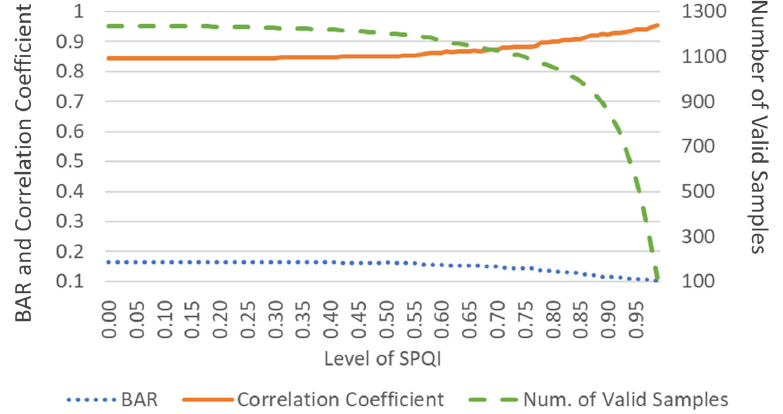
Figure 5. Trade-o ff between the number of valid samples and the agreement (BAR or correlation Figure 5. Trade-off between the number of valid samples and the agreement (BAR or correlation coefficient) of log HF between the smartphone PPG (Tangent) and reference ECG. coe ffi cient) of log HF between the smartphone PPG (Tangent) and reference